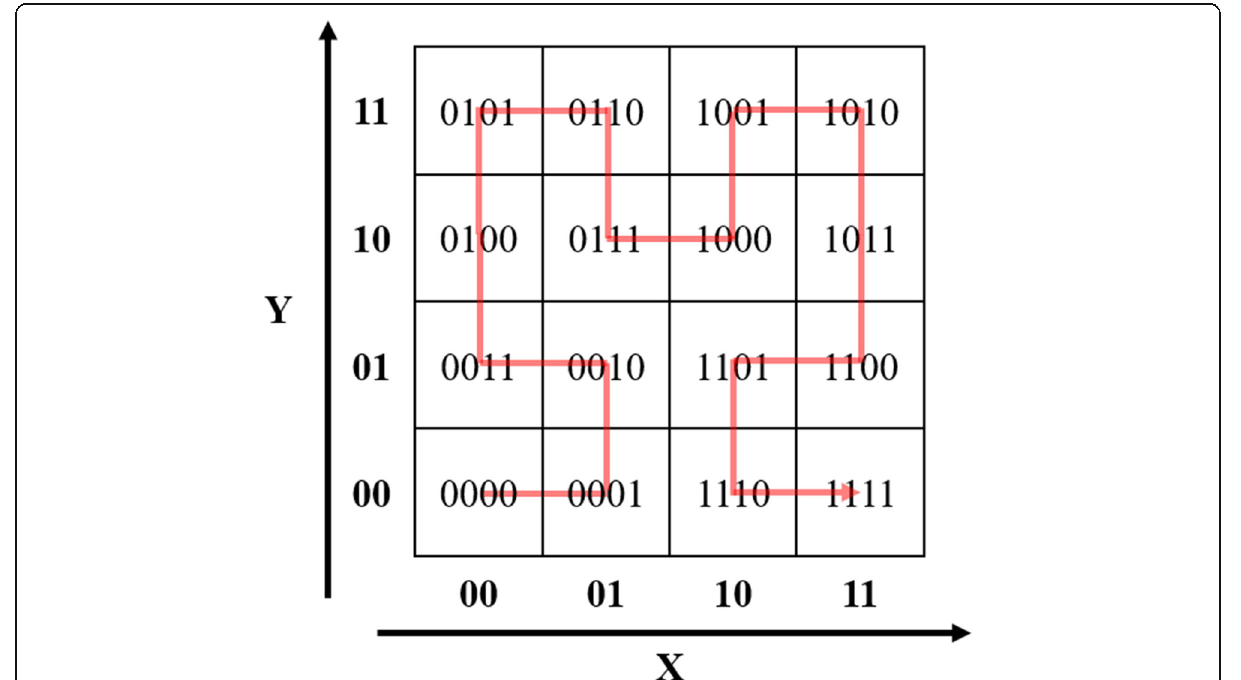
Fig. 4 The second order Hilbert space-filling